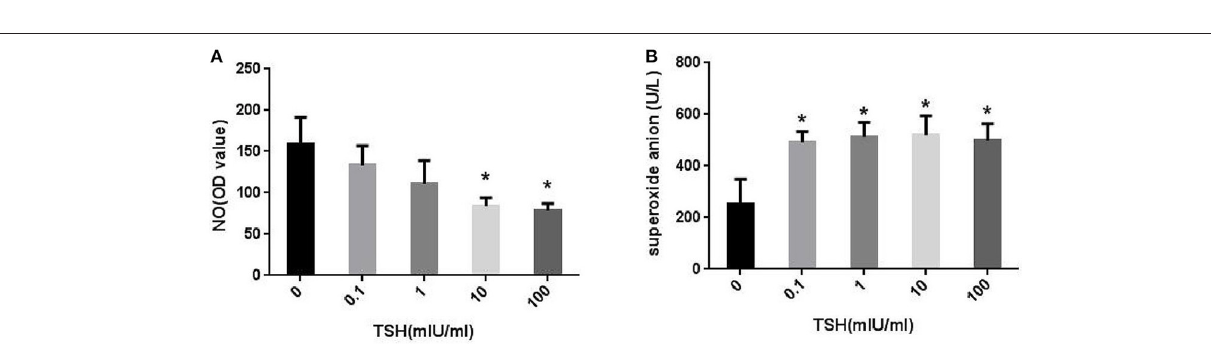
Frontiers in Endocrinology |